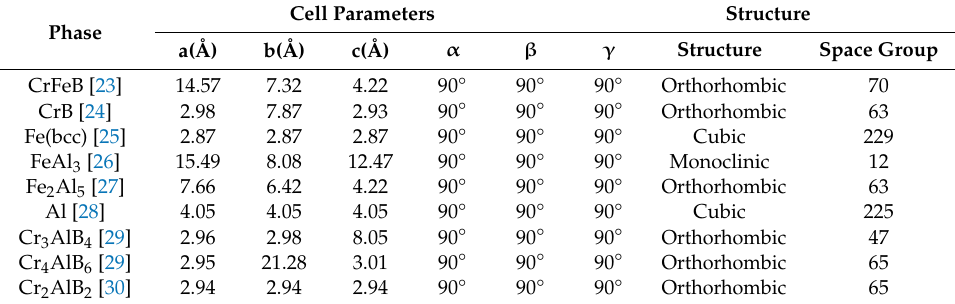
Table 2. The crystal structure of phases used for PLS identification by EBSD. Cell Parameters Structure Phase